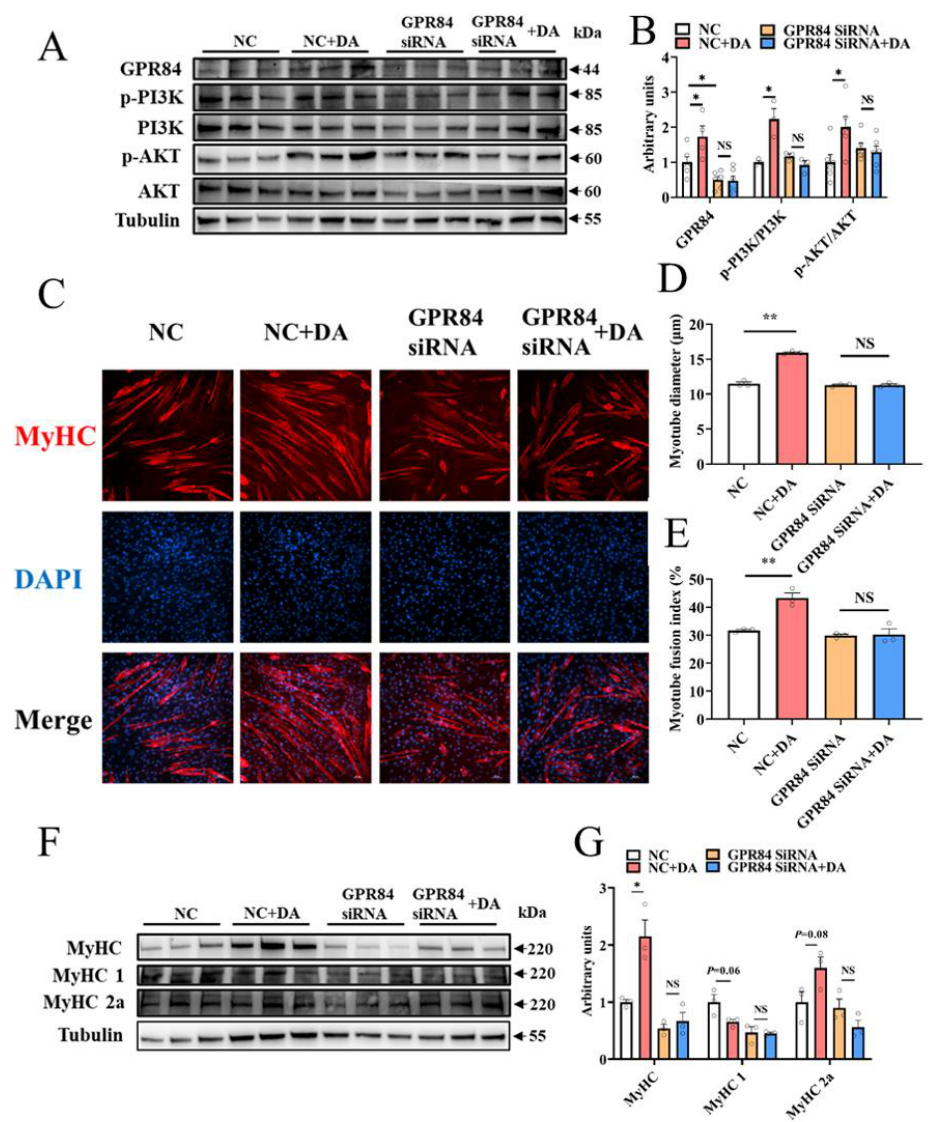
Figure 5. Decanoic acid mediates C2C12 cell differentiation through the GPR84 and PI3K/AKT signaling pathways. ( A , B ) The protein expression level of GPR84 and PI3K/AKT signaling pathways in C2C12 cells. ( C – E ) Immunocytochemistry of myotubes in C2C12 cells. Red: MyHC; blue: DAPI. ( F , G ) The protein expression level of MyHC, MyHC 1 and MyHC 2a in C2C12 cells. NS indicates no significant differences. * p < 0.05 versus the control group, ** p < 0.01 versus the control group.